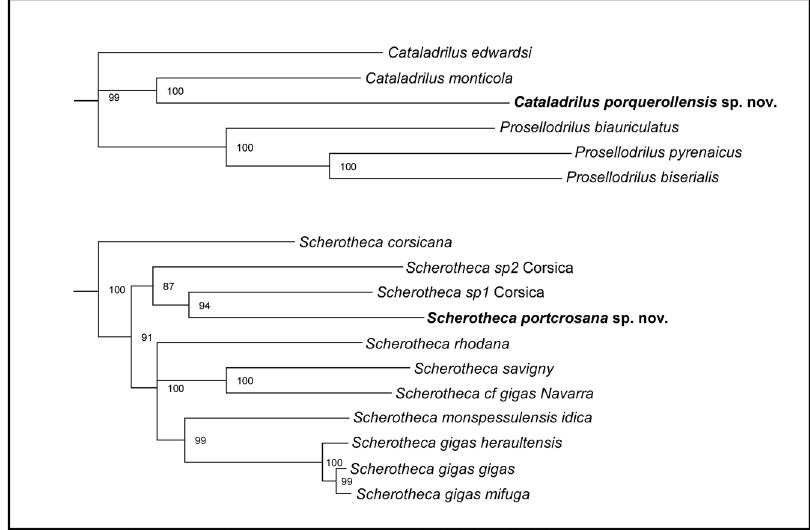
Fig. 1. Detail of the clades including the species Cataladrilus porquerollensis Marchán & Decäens sp. nov. and Scherotheca portcrosana Marchán & Decäens sp. nov. obtained by Bayesian phylogenetic analysis of the concatenated sequence of molecular markers COI –16S– ND1 –28S. The complete phylogenetic tree is shown in Appendix 2. posterior probability support values are shown besides corresponding